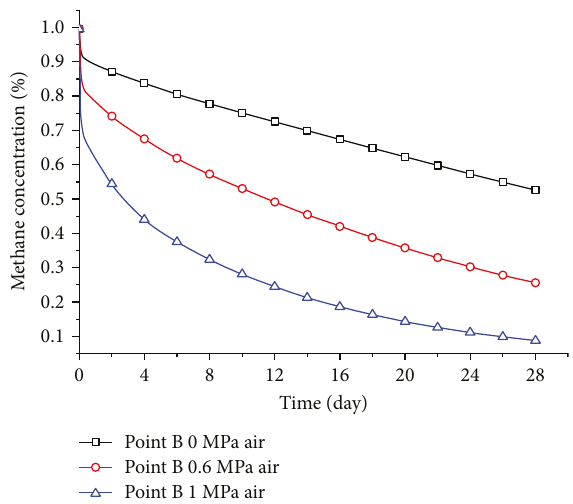
Figure 12: Methane concentration varies with